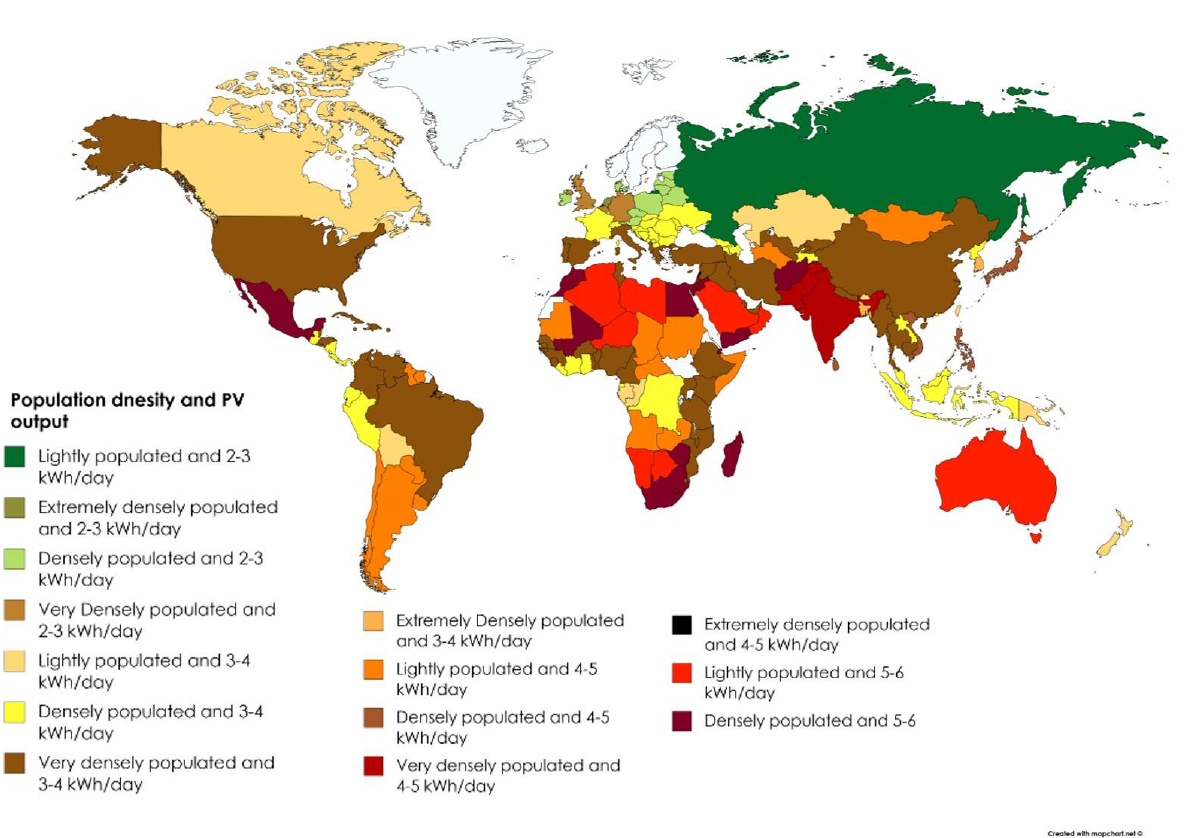
Figure 1. Population in the world without access to electricity (in millions) [49]. Source: IEA (2019) SDG7: Data and Pro- jections. All rights reserved.